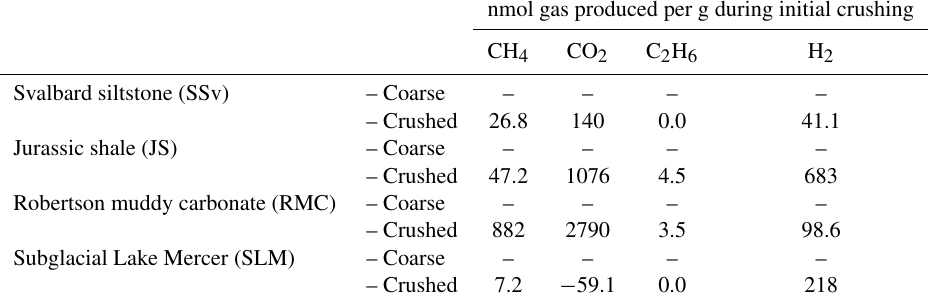
Table 2. Gases released to ball mill headspace during high-energy crushing (500rpm for 30min) of sedimentary rock (SSv, JS and RMC) and subglacial sediment (SLM) samples. Crushing was conducted under air; therefore, values shown in this table have been corrected for the initial concentration of atmospheric gases in the ball mill